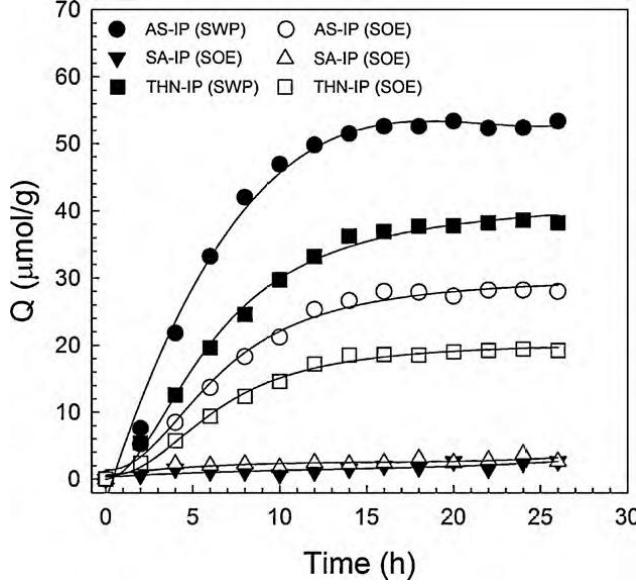
Figure 6. Rebinding profiles of aspirin (AS), salicylic acid (SA) or 1,2,3,4-tetrahydro-1- naphthol (THN) of the MIPs extracted templates using the Soxhlet extraction (SOE) or the swelling process (SWP). Reprinted from Byun et al. [39] with permission from